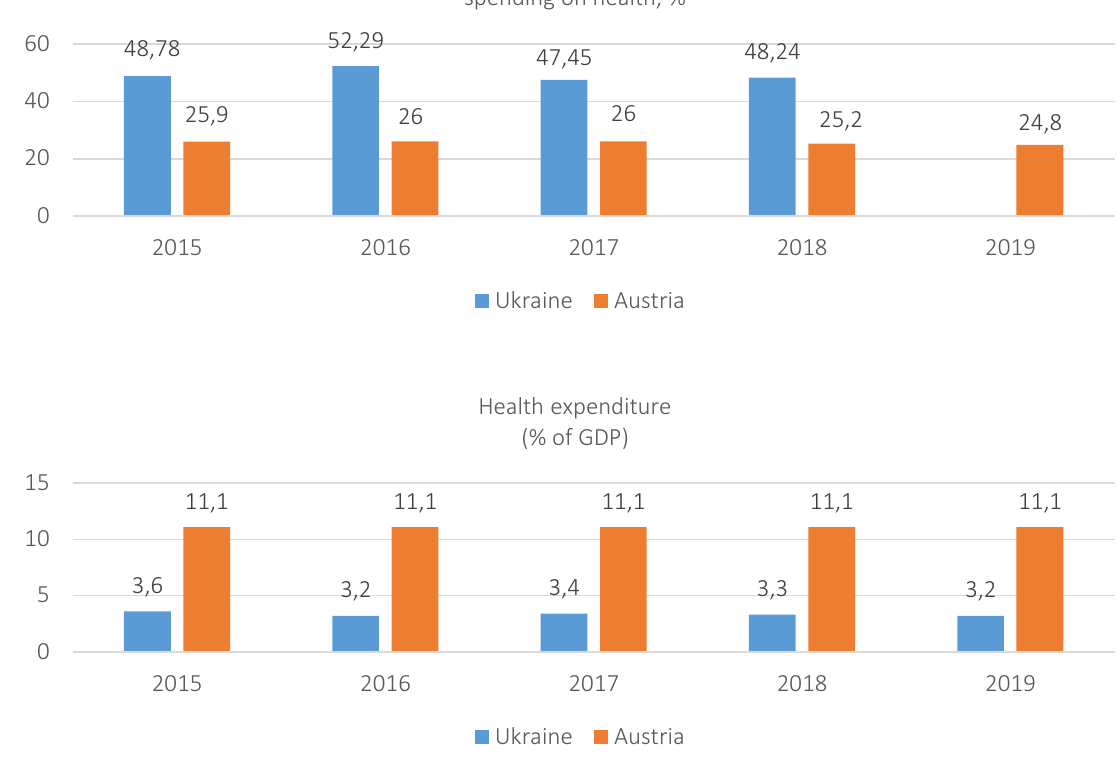
Table 5. Key indicators of healthcare expenditures in Ukraine and Austria in 2018